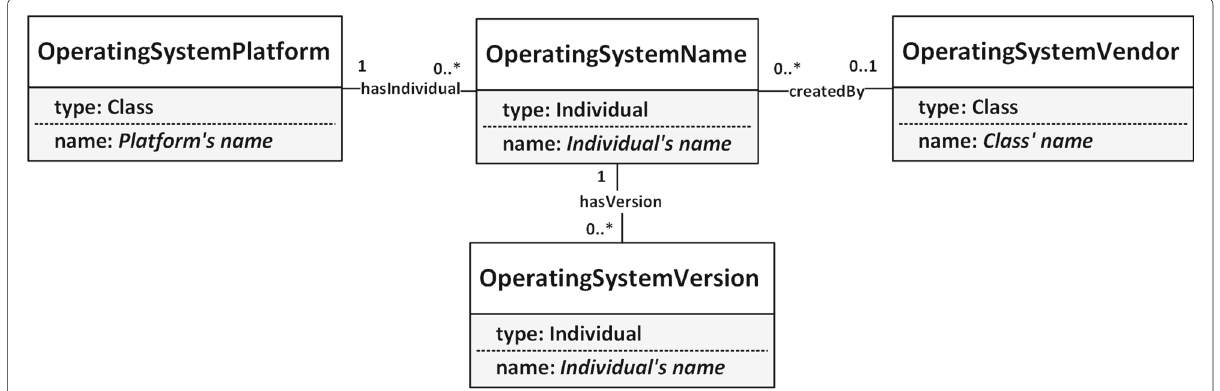
Fig. 3 Standardization of operating system